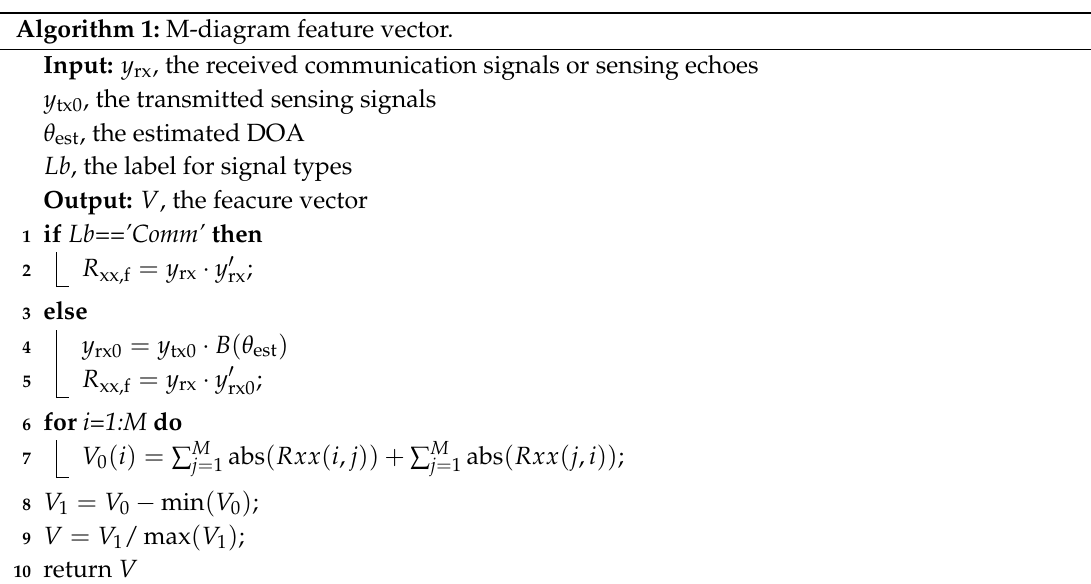
Algorithm 1: M-diagram feature